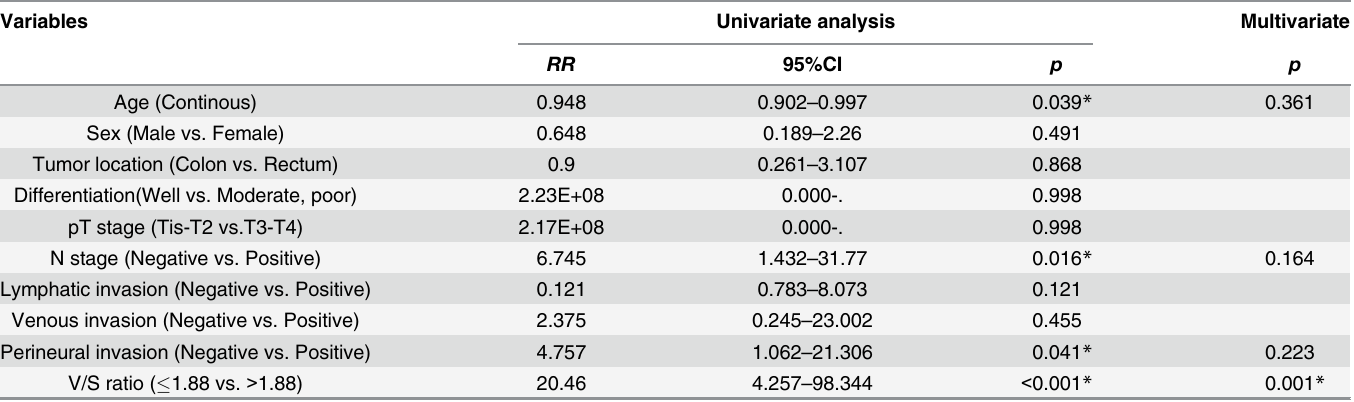
Table 4. Uni- and multivariate analyses for predicting distant metastasis.